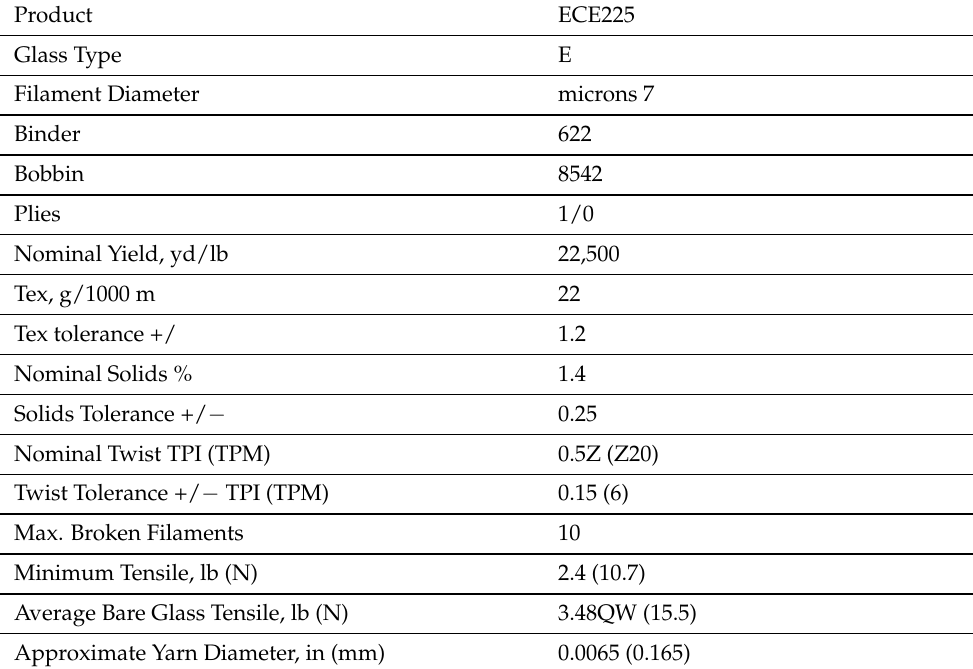
Table 1. E-glass fiber yarns specs